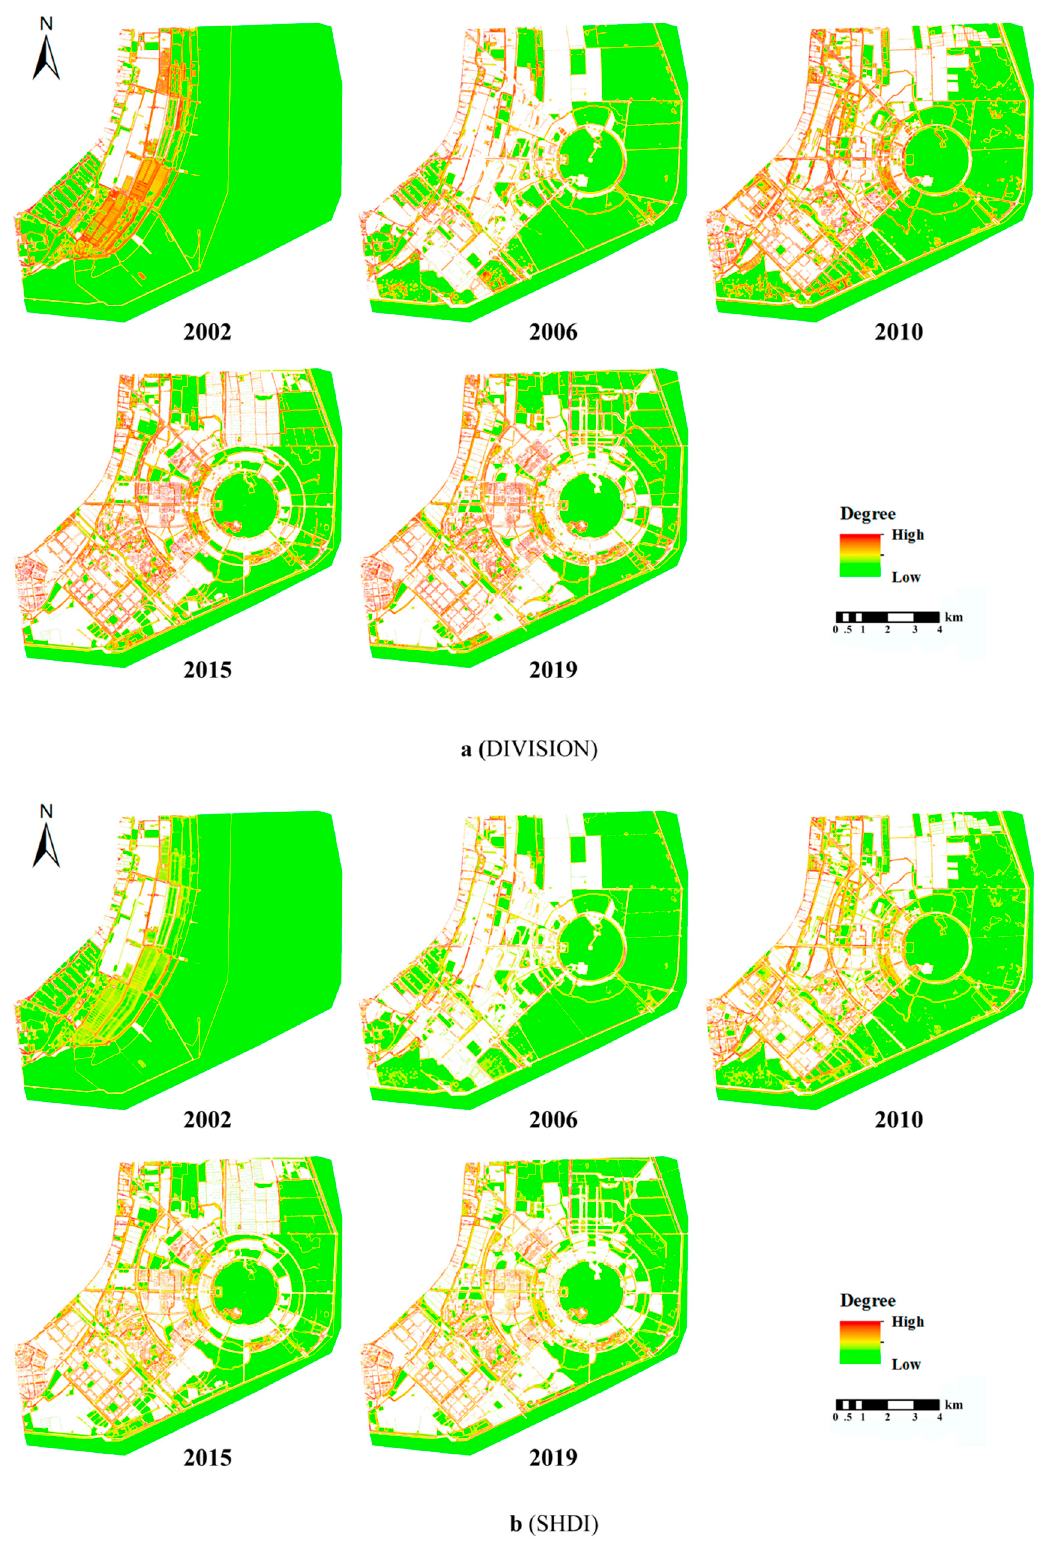
Figure 7. Spatial distribution of landscape fragmentation ( a ) (DIVISION) and diversity ( b ) (SHDI) of high-level habitats.